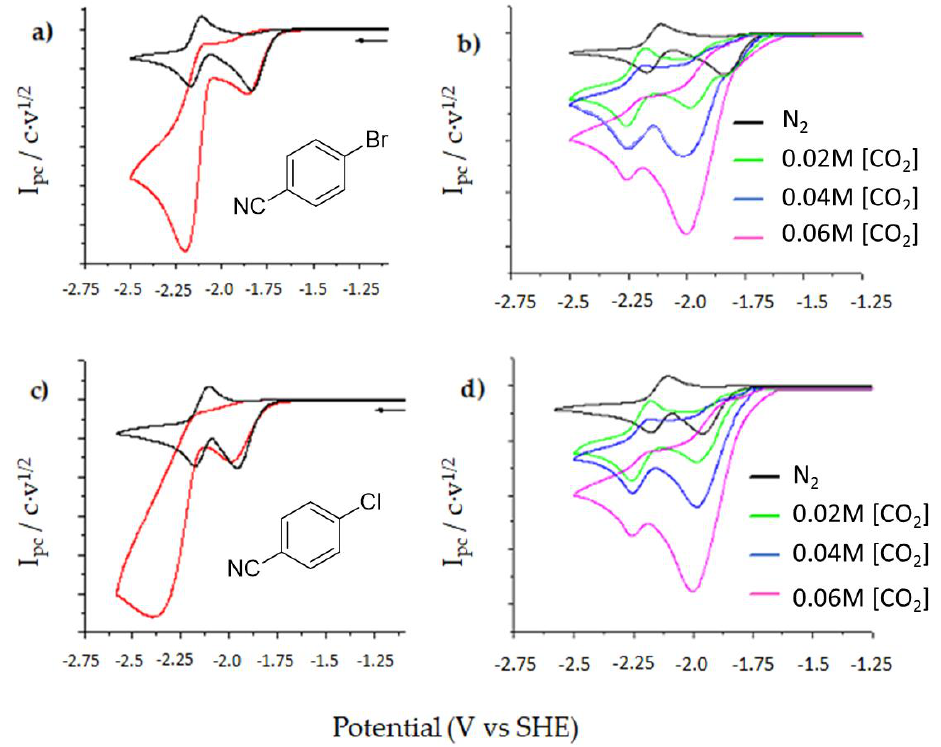
Figure 6. Cyclic voltammograms in DMF / 0.1M under nitrogen atmosphere and 20–60 mM [CO 2 ] atmosphere using a solution of 10 mM of 6 ( a ) with GC ( b ) Ag. A solution of 10 mM of 7 with ( c ) GC and ( d ) Ag. Scan rate 0.5 V s −1 .